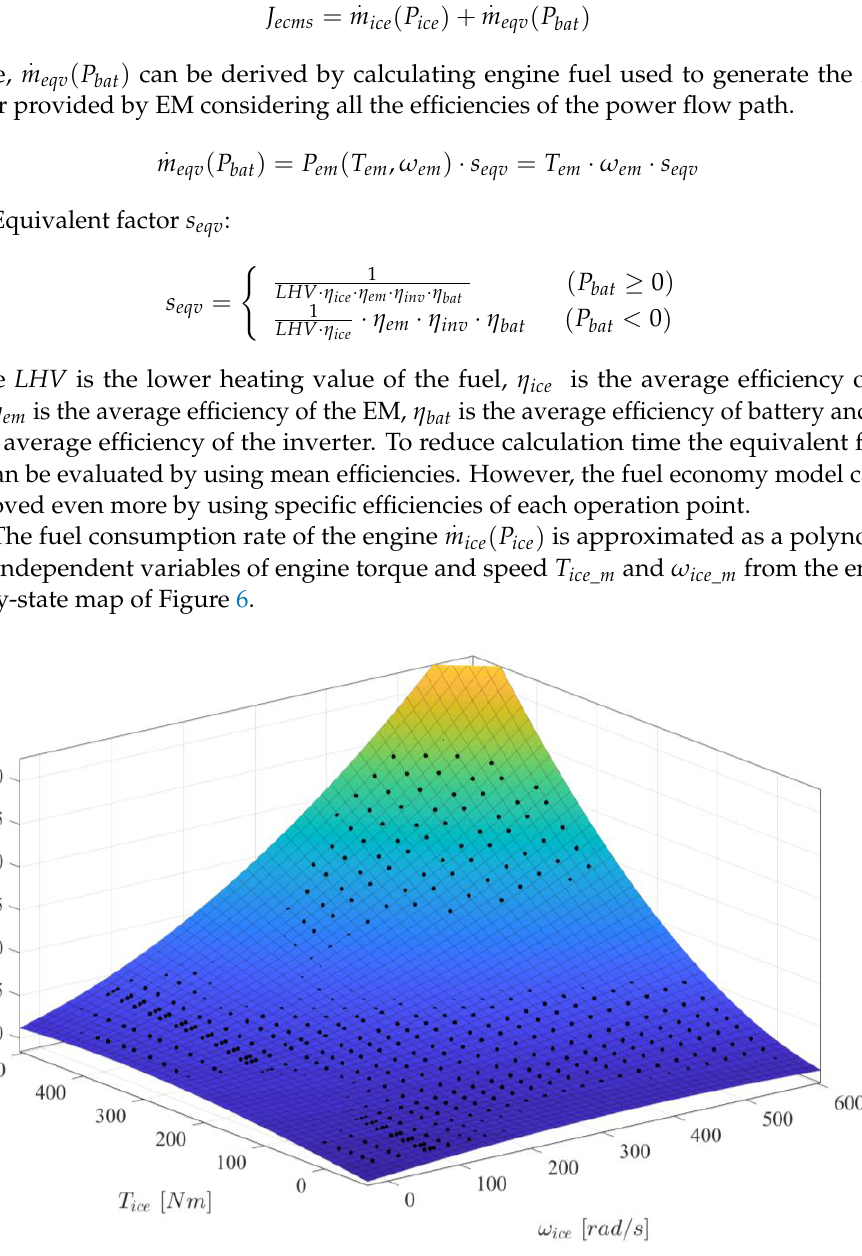
Figure 6. Curve fitting of the engine fuel consumption rate by engine torque and rotation speed [18]